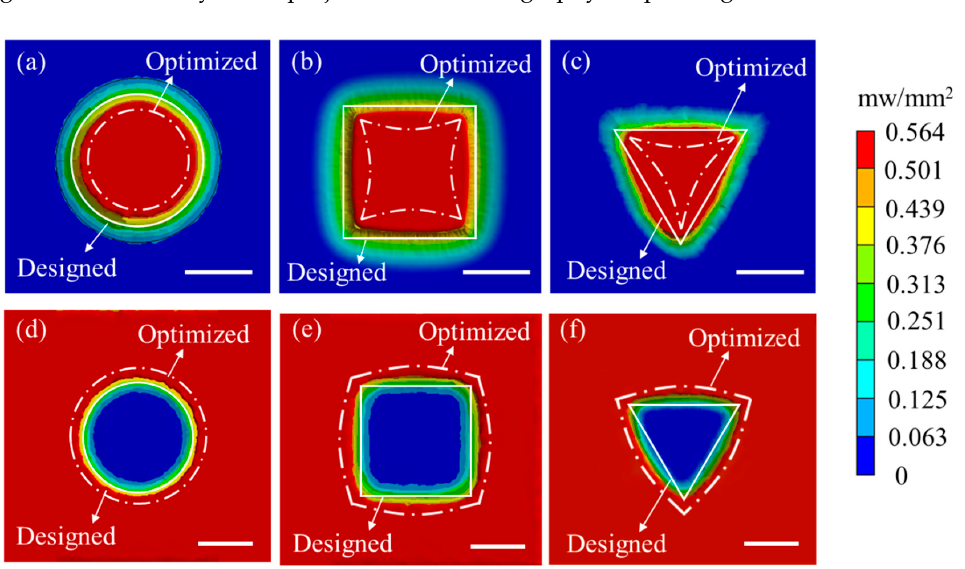
Figure 6. The simulation results for the power intensity distribution. ( a ) The optimized circle pattern, ( b ) the optimized square pattern, ( c ) the optimized triangle pattern, ( d ) the optimized pattern for the circular hole, ( e ) the optimized pattern for the square hole and ( f ) the optimized pattern for the regular triangle hole. Scale bar: 50 µm.